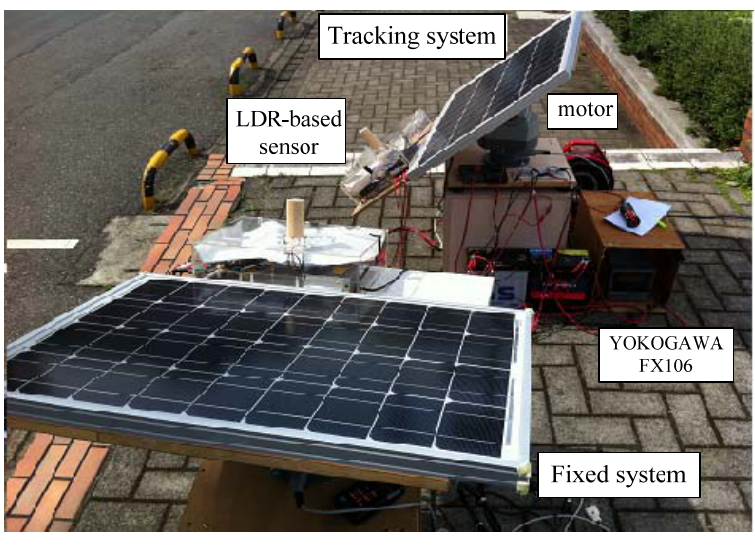
Figure 8. Actual photograph of the experimental prototype.